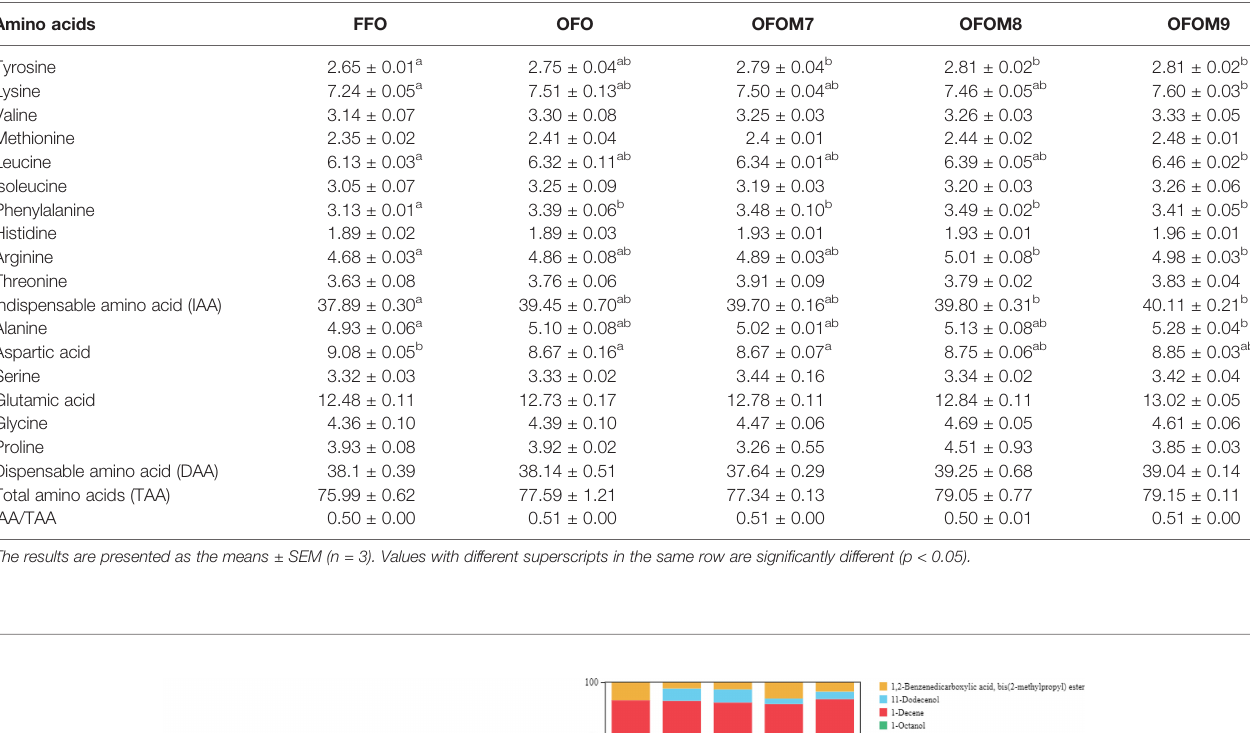
TABLE 7 | Muscle amino acids of grouper fed different diet.